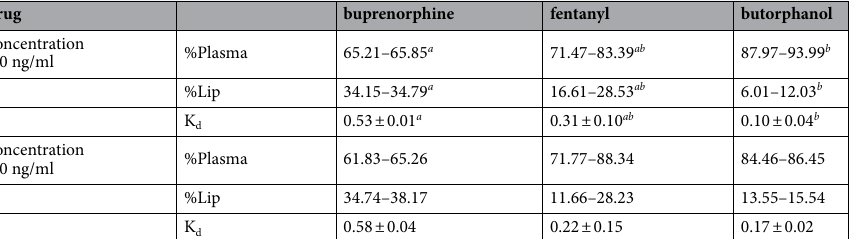
Table 3. In vitro disposition of the investigated opioids, between aqueous plasma and lipid layer. %Plasma— percentage of the drug that was found in lipid-free plasma, %Lip—percentage of the drug that was found in the upper lipid layer, K d —distribution coefficient evaluated in rabbit plasma and lipids originated from Intralipid, n = 3, values that do not share a superscript letter at the same row are considered statistically different, lack of superscript latter indicates lack of statistical difference. No differences were found between tested concentrations for the same drugs.